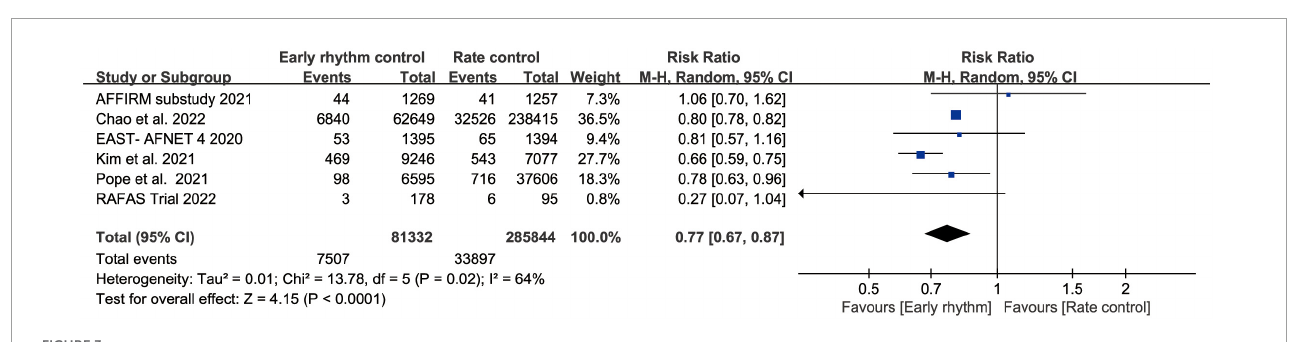
FIGURE3 Forest plot showing risk of stroke between early rhythm group and rate group.